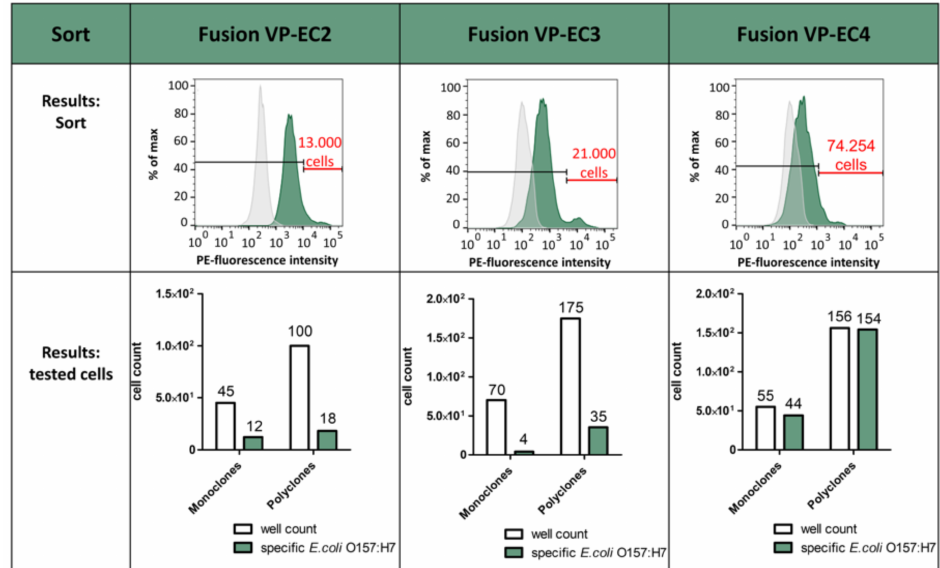
Figure 5. Results of the fusions with VP-EC2, VP-EC3, and VP-EC4. The fusions with the correspond- ing results of the tested monoclones and polyclones are listed here. The number of sorted cells is presented in red. Only cells from the hybridoma cell pool that showed a high PE signal were sorted. The sorted cells were cultured for 2 days, separated, and then tested for antigen-specific antibodies in flow